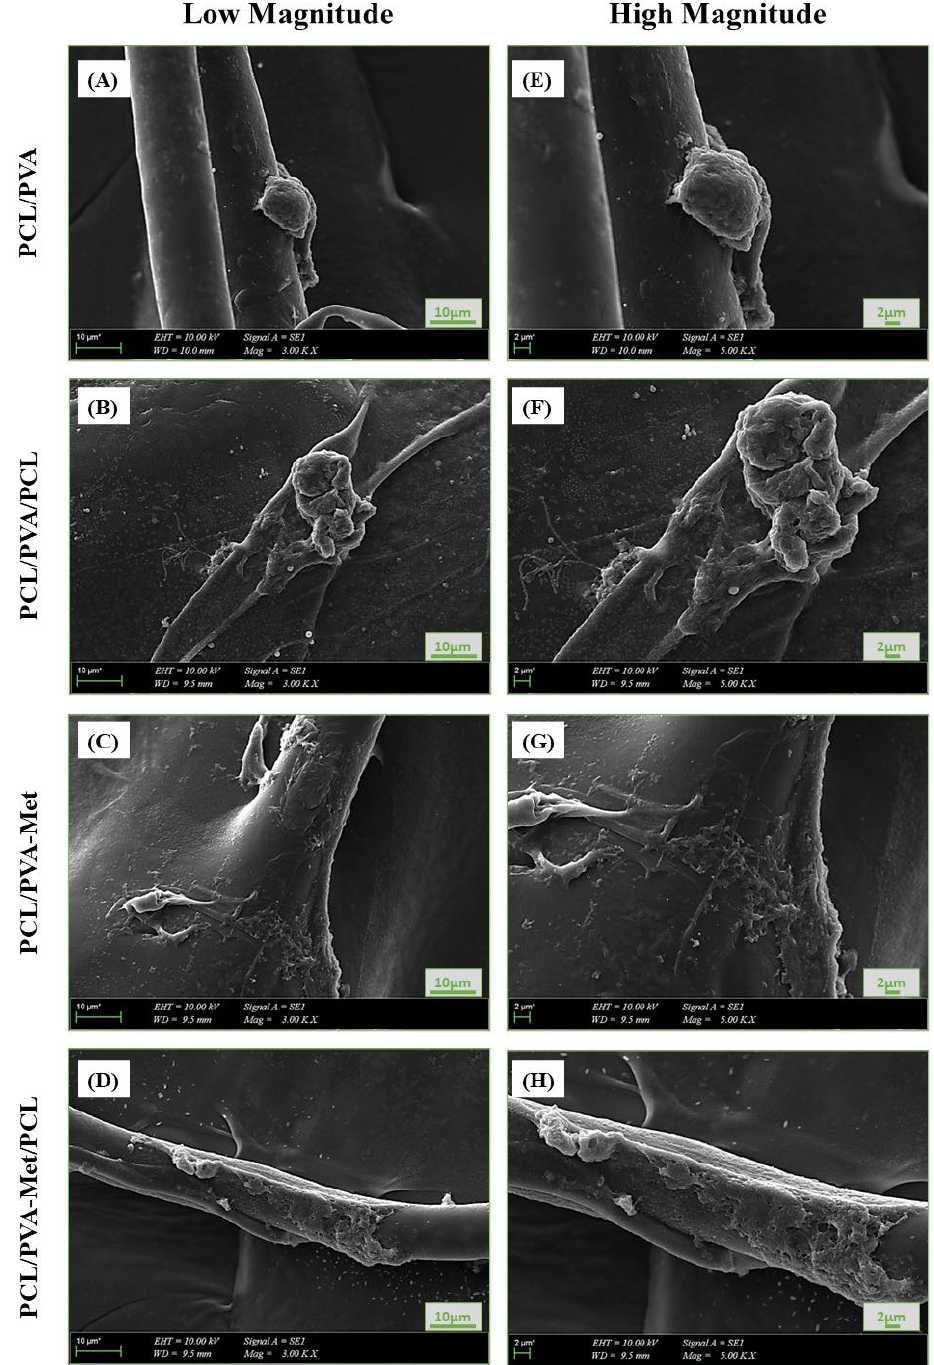
Figure 8. Morphology of the fibroblast cells attached on the scaffolds post 7 day incubation: SEM images of ( A , E ) PCL/PVA, ( B , F ) PCL/PVA/PCL, ( C , G ) PCL/PVA-Met, and ( D , H ) PCL/PVA-Met/PCL.